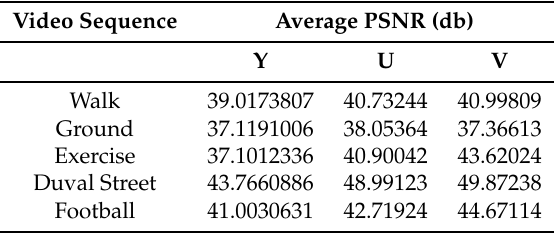
Table 3. Average Peak Signal-to-Noise Ratio (PSNR) for Y, U, V channels of 260 random video frames for all five